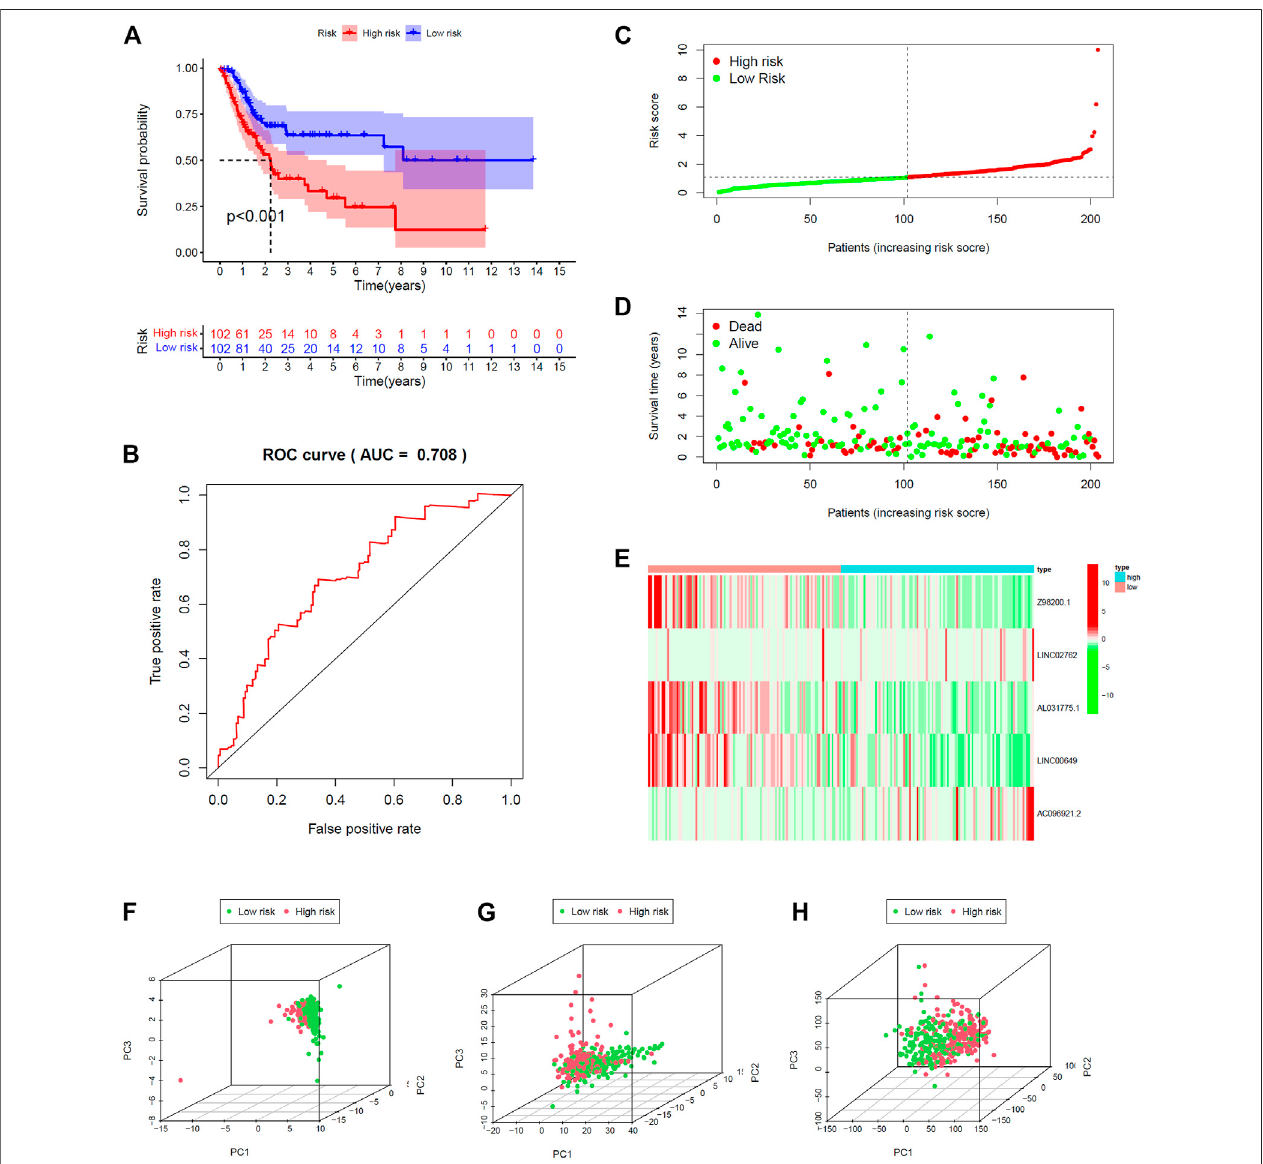
FIGURE 4 | Validation of prediction model in training set. (A) Kaplan – Meier survival curves revealed OS comparison of the high- and low-risk groups. (B) Receiver operatingcharacteristic(ROC).Distributionofriskscores (C) andsurvivalstatus (D) . (E) Expressionheatmapsofthe fi veferroptosis-prognosis – relatedlncRNAs. (F,G,H) Principal component analysis (PCA) was used to explore the distribution of samples in different risk group.